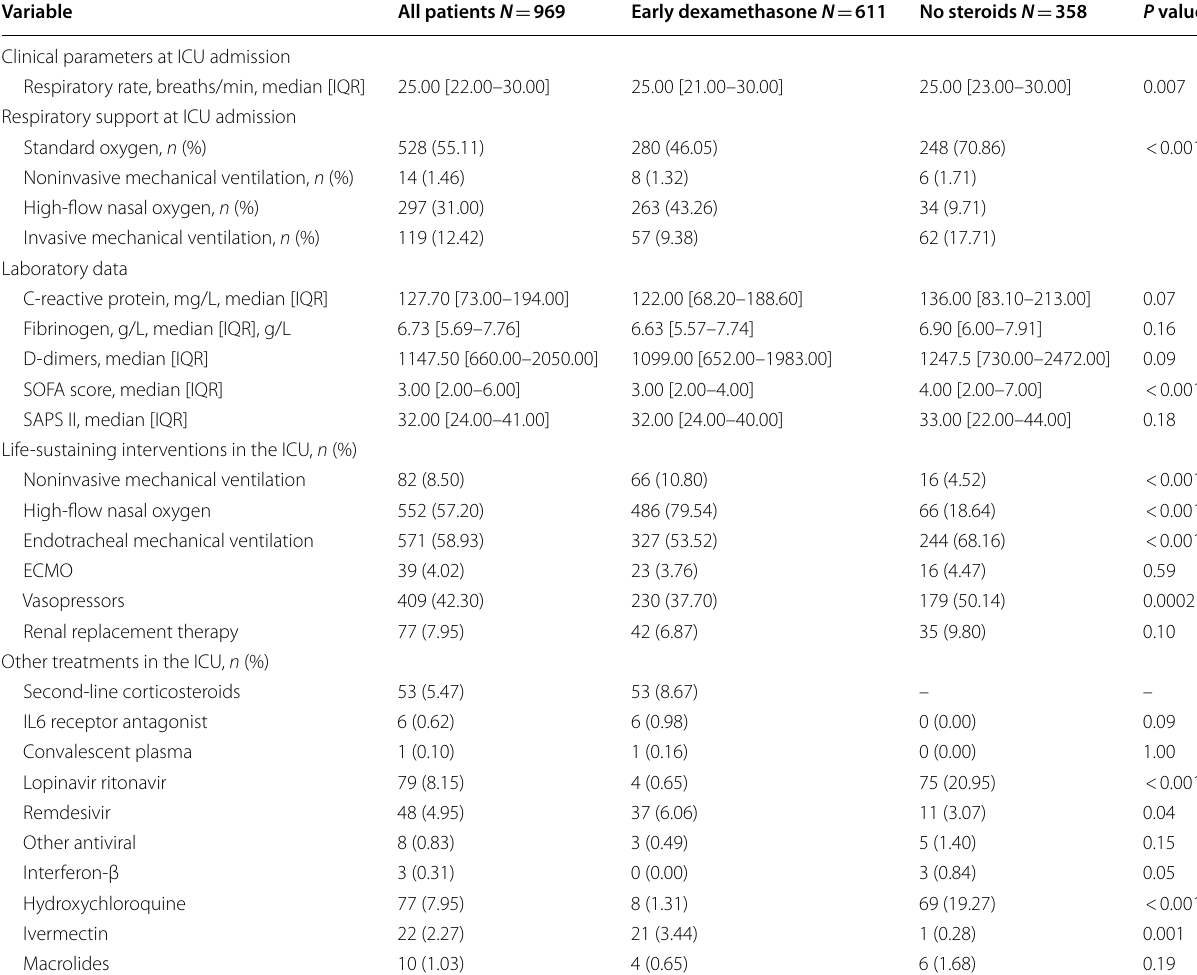
Table 2 Clinical and laboratory features and ICU